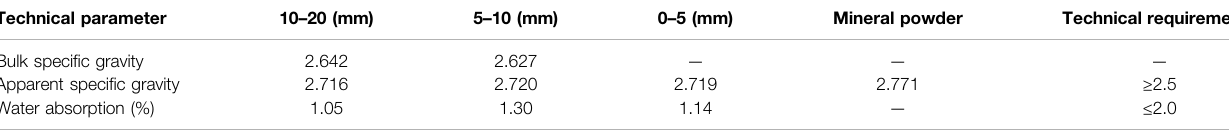
TABLE 1 | Speci fi c gravity and water absorption test results of aggregates with different particle sizes and mineral powder. Technical parameter